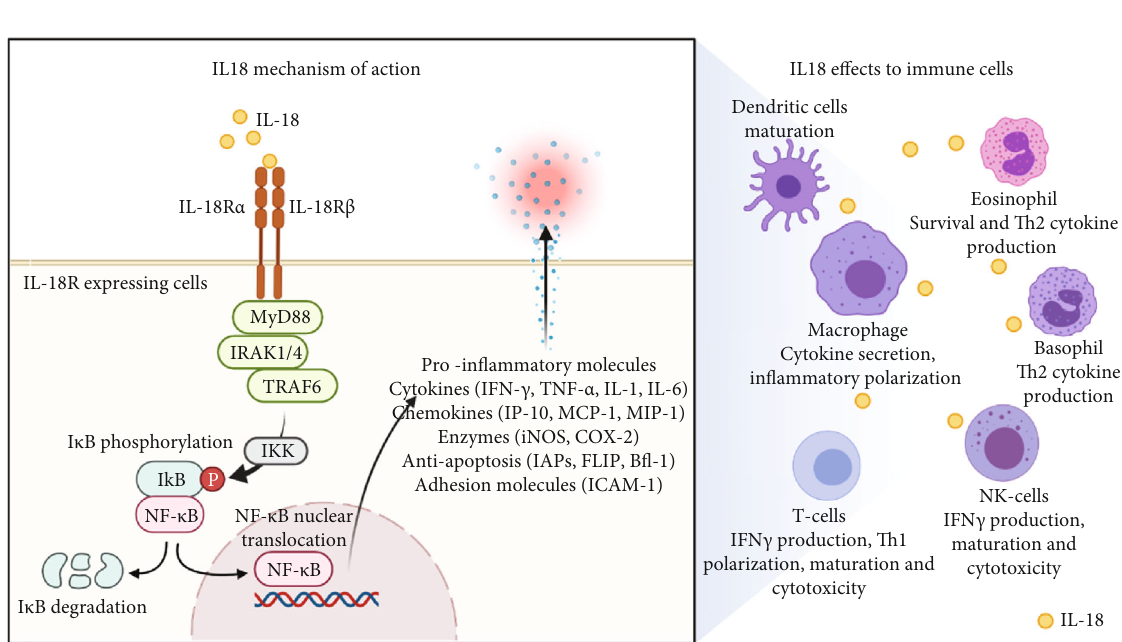
Figure 1: The mechanism of action of IL-18-facilitated in fl ammatory responses in various immune cells and its possible e ff